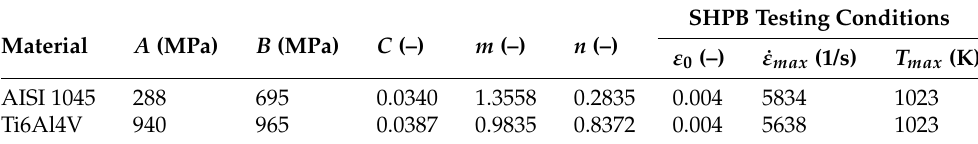
Table 4. Johnson-Cook parameters identified for AISI 1045 and